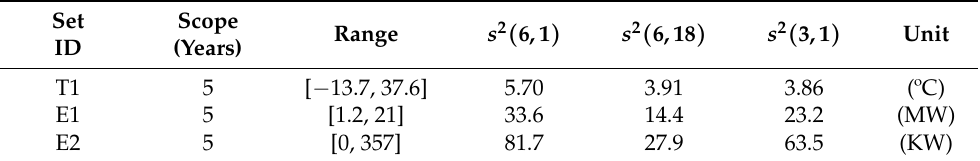
Table 1. Main characteristics of the data-sets used in the tests.